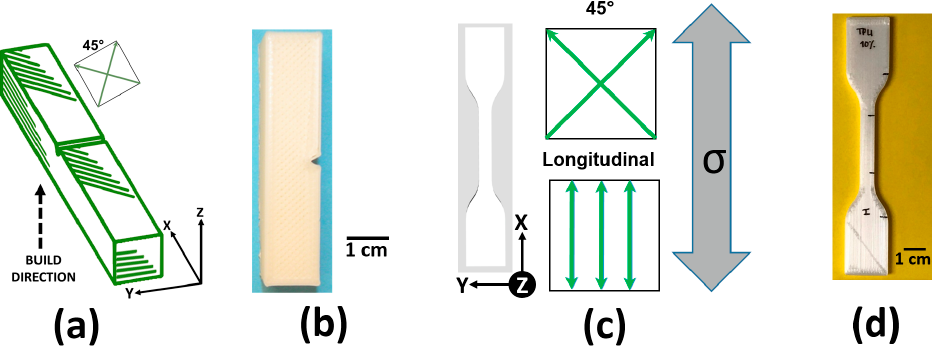
Figure 2. The mechanical testing specimen types used in this study: ( a ) schematic of an Izod impact test specimen with print orientation and raster pattern details indicated, ( b ) example of an additively manufactured Izod impact test specimen used in this study, ( c ) schematic of an ASTM D638 [44] Type IV tensile test specimen with print orientation and raster pattern details indicated as well as relation to applied stress, and ( d ) example of an additively manufactured Type IV tensile test specimen used in this study. Table 1. Printer parameters for the blends used in this study 1 .